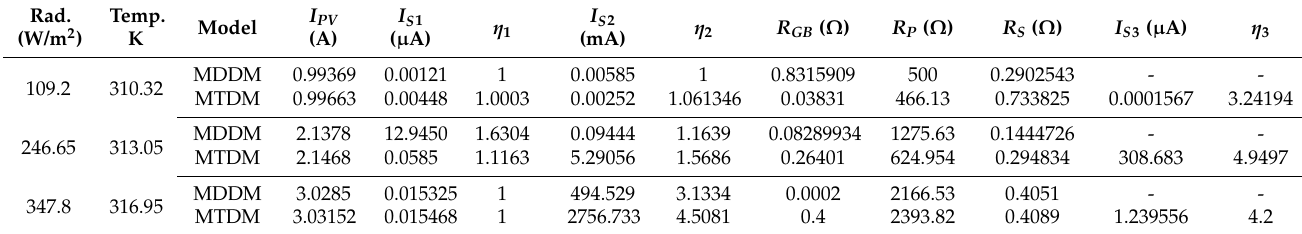
Table 4. The extracted parameters for MDDM and MTDM by EHO algorithms for CS6P-240P solar module at different irradiance and temperature levels.